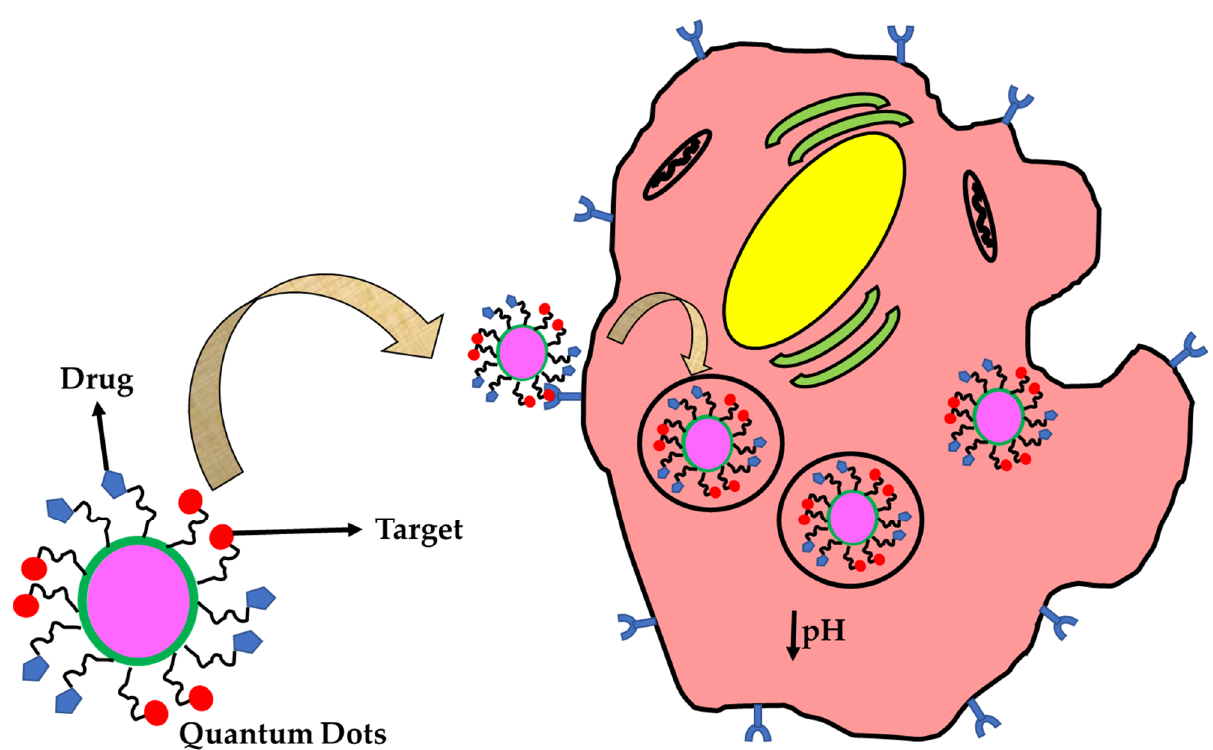
Figure 2. Scheme illustrates the intracellular uptake of QDs.